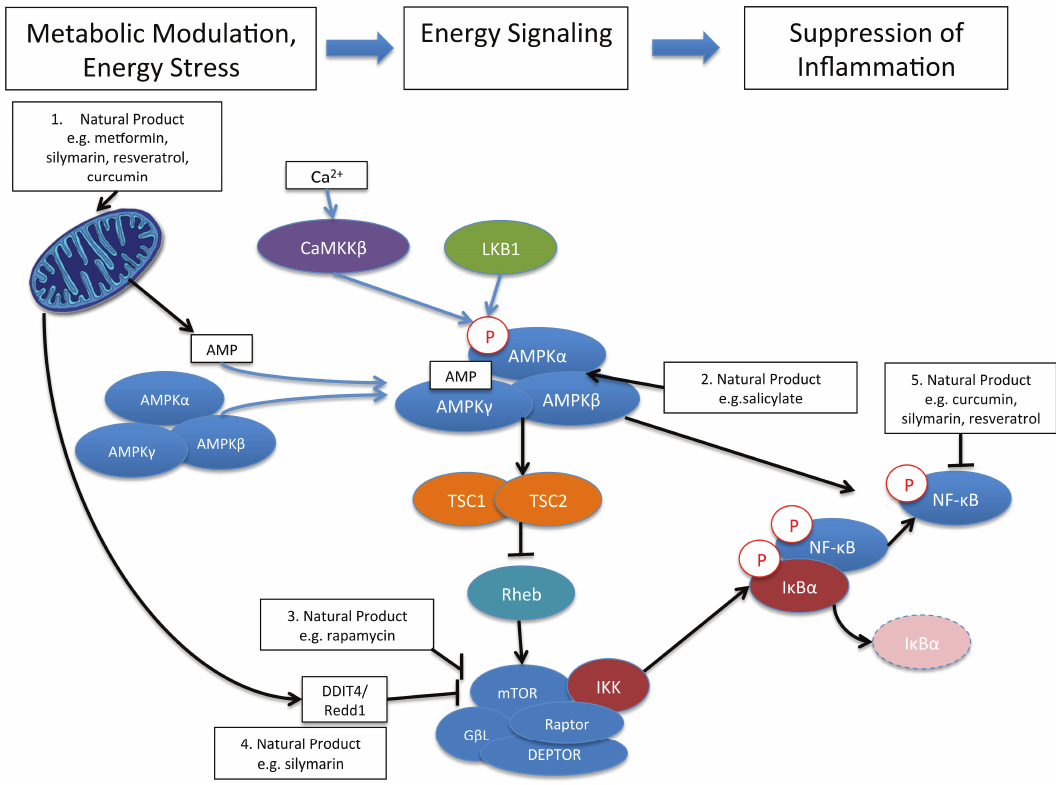
Figure 2. Metabolic Rules of Engagement of Natural Products with Cells. Some of the earliest cellular responses to natural product exposure include the alteration of mitochondrial function which increases the AMP:ATP ratio, leading to activation of AMPK by phosphorylation (1). Natural products like salicylate can also directly bind to and activate AMPK (2). AMPK activation suppresses Rheb, an upstream activator of mTOR signaling. Thus, AMPK activation by natural products can lead to mTOR inhibition. Natural products like rapamycin can also directly bind to and inhibit mTOR signaling (3). The alteration of mitochondrial energetics may be involved in natural product induction of DDIT4, a novel upstream inhibitor of mTOR (4). Finally, activation of AMPK and inhibition of mTOR by natural products may be directly involved in the suppression of pro-inflammatory signaling such as that mediated by NF- κ B (5). For mTOR, there is evidence that IKK interacts with mTORC1 to mediate the connection of mTORC1 to NF- κ B, while for AMPK, the route to NF- κ B is not presently clear. Citations of studies supporting these interactions are provided in text. Note that the tri-molecular complexes of IKK (IKK α , IKK β , and IKK γ ), and the bimolecular complex of NF- κ B are simplified as single proteins. Moreover, only the mTORC1 and canonical NF- κ B pathways are shown.